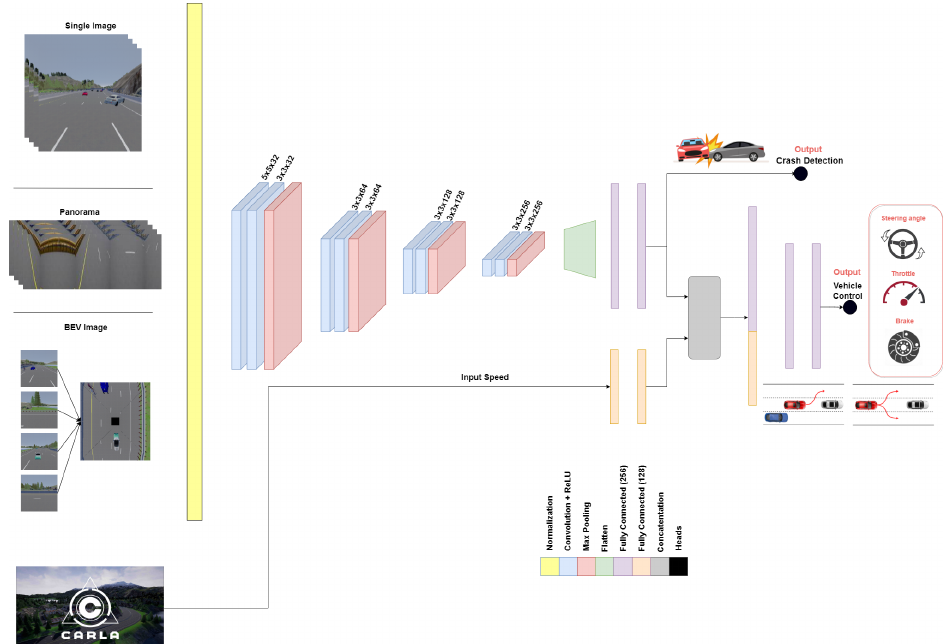
Figure 9. SDC-Net: multitask deep neural